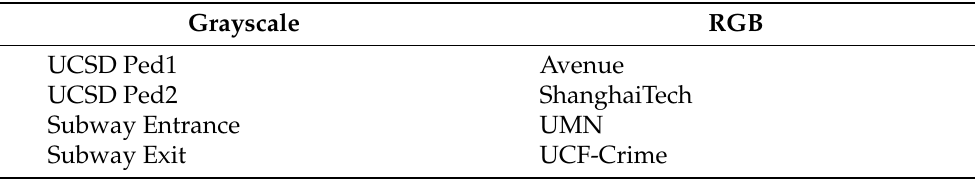
Table 12. Based on the color